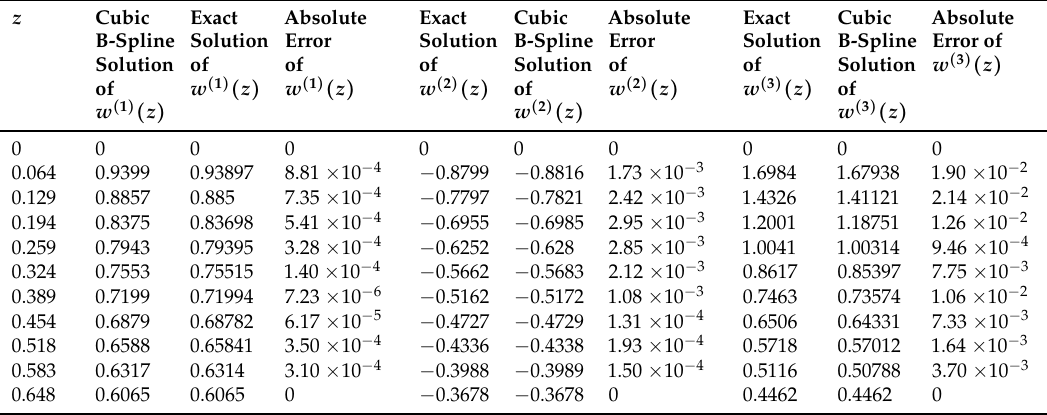
Table 16. Absolute errors at all derivatives at h = 1 Problem 5.